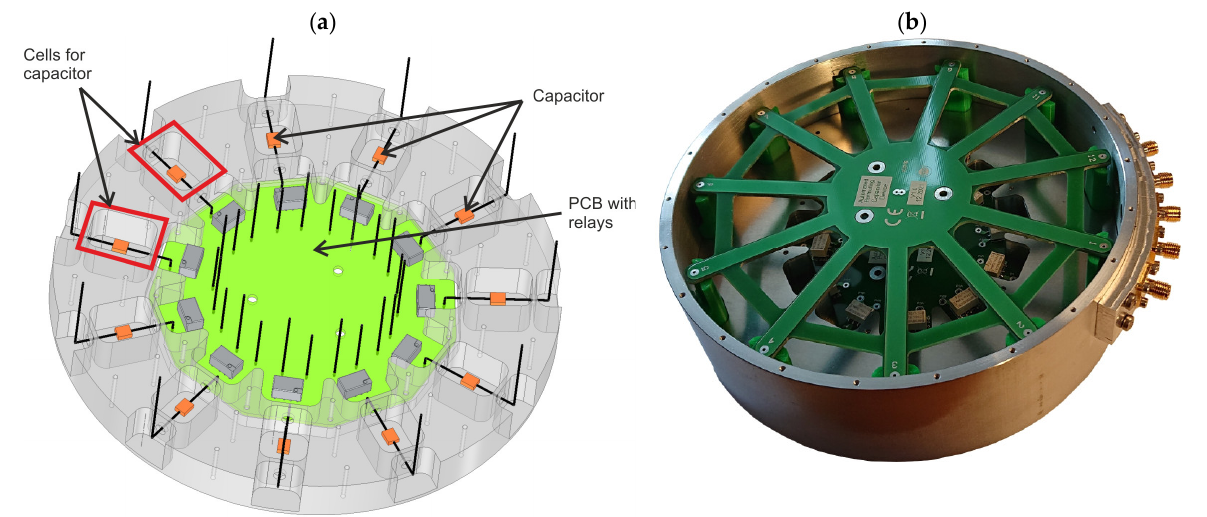
Figure 4. Switched capacitor module (SCM): ( a ): a 3D model; ( b ): photograph.